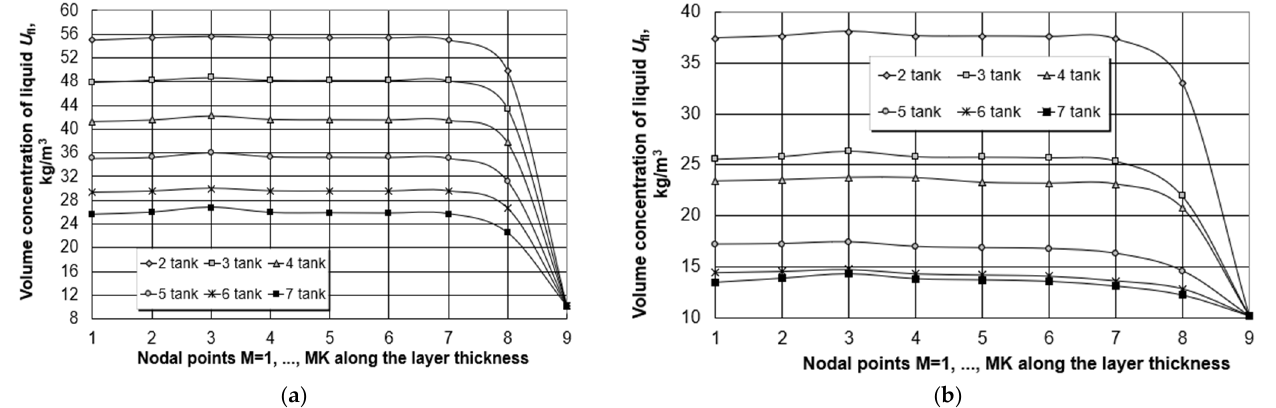
Figure 5. Change in the volume concentration of the liquid phase U fl during compressed castor seed frying along the layer height in sections r = R /2 ( a ) and r = R ( b ) in each vat at the time of 8 min.